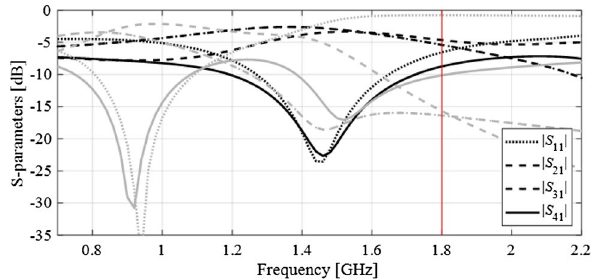
Figure 1. Scattering parameters of an example compact branch-line coupler (consider in “Example 1: Miniaturized branch-line coupler (BLC)”). The target operating frequency is 1.8 GHz, marked using a vertical line. This target is attainable by means of local search when starting from the design represented using the black lines; however, it is not attainable from the design marked using the gray lines. The latter is due to the fact that the operating bandwidth of the circuit is too far away from the target